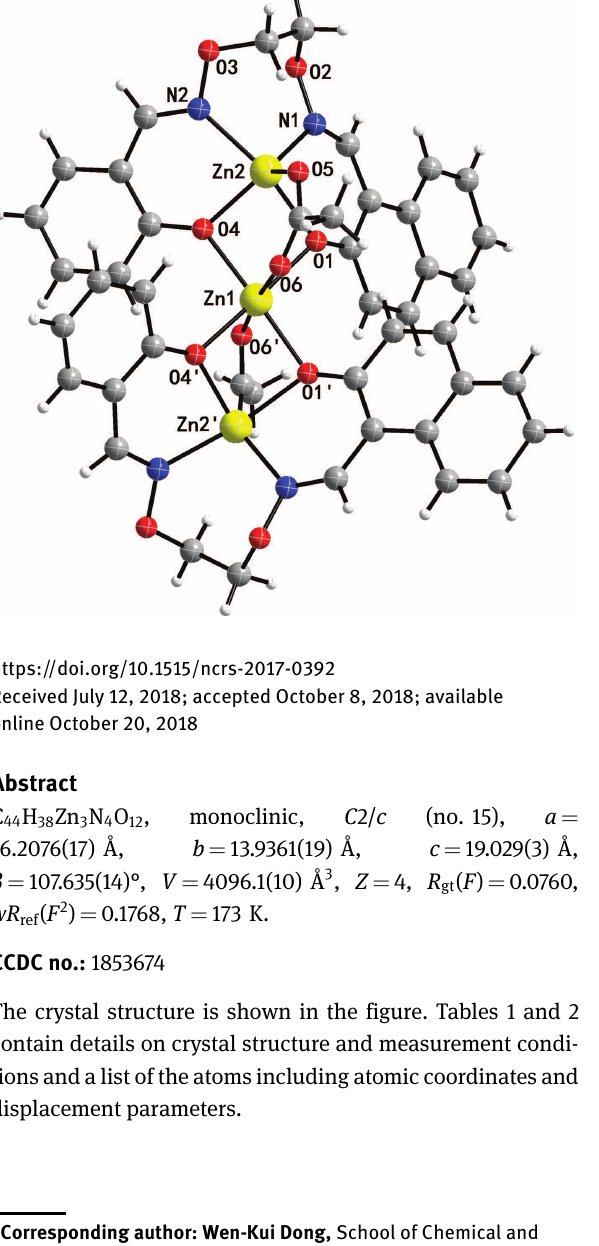
Table 1: Data collection and handling.